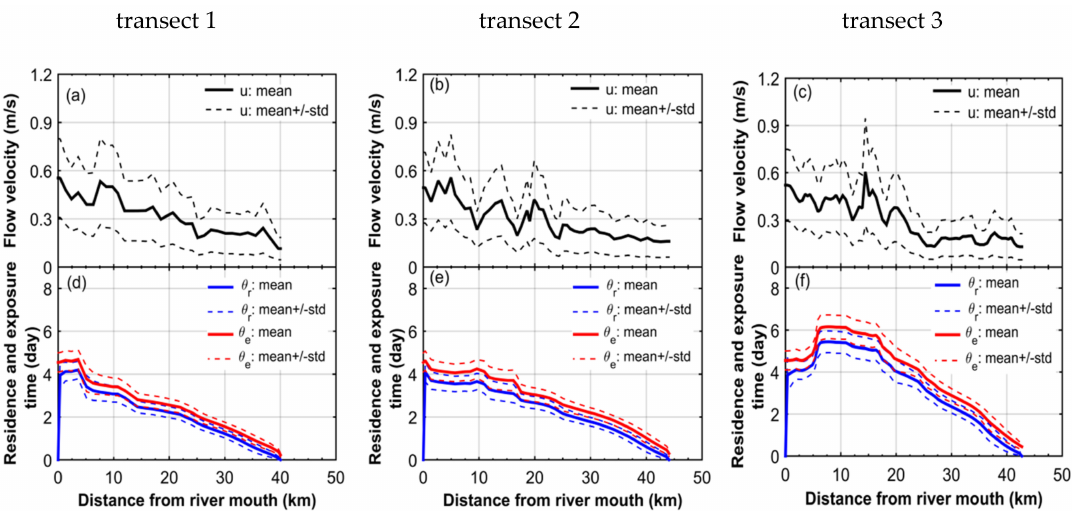
Figure 9. Simulated values of water velocity along the: ( a ) transect 1; ( b ) transect 2; ( c ) transect 3 (see Figure 3) and simulated values of residence and exposure times along; ( d ) transect 1; ( e ) transect 2; ( f ) transect 3 (see Figure 3) for the high flow period.